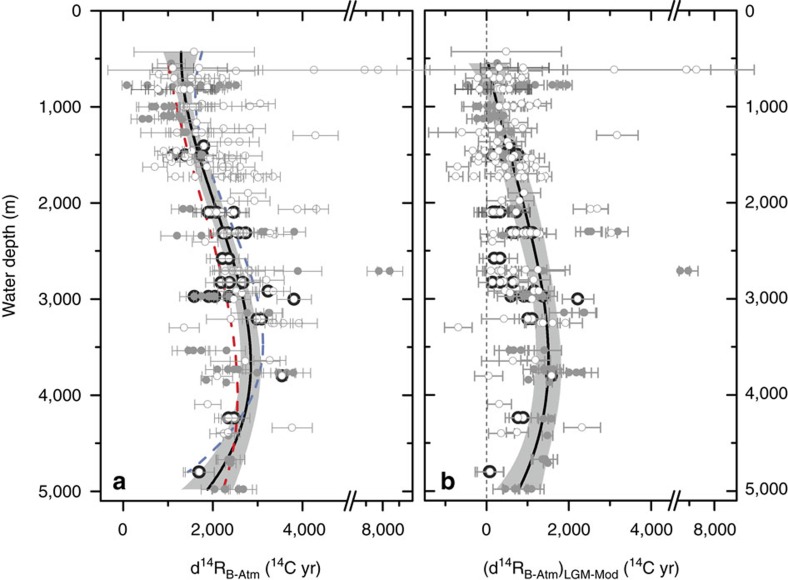
Deep ocean versus atmosphere radiocarbon-age offsets from the Last Glacial Maximum.(a) New (black filled symbols, this study) and compiled deep ocean versus atmosphere radiocarbon age offsets (i.e., d14RB-Atm) from the Last Glacial Maximum (open grey circles, Indo-Pacific; filled grey circles, Atlantic). Also shown are polynomial ‘best-fits’ for all data (solid black line, with shaded 95% confidence intervals), for the Pacific (dashed blue line) and for the Atlantic (dashed red line). (b) Data from the left panel expressed as differences relative to the pre-industrial ‘background’ B-Atm at each location (Δ(d14RB-Atm)LGM-Mod), indicating the radiocarbon ‘age’ of the LGM ocean relative to the pre-industrial era. Errors represent 1σ uncertainty derived from the corresponding analytical uncertainties in radiocarbon dates and estimated uncertainties in reservoir ages.